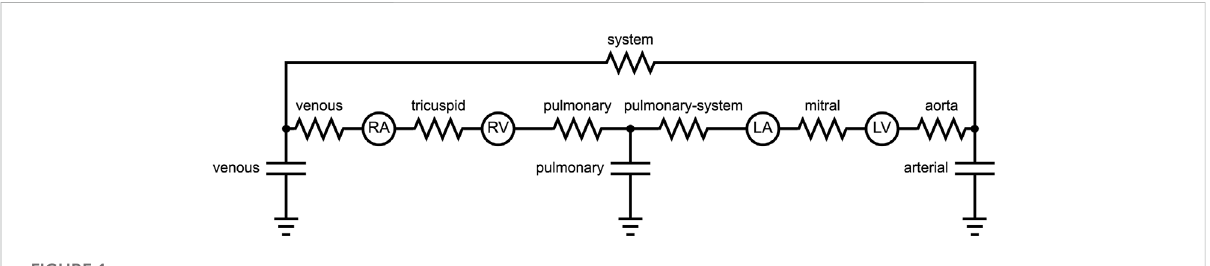
FIGURE 1 Electrical representation of the blood fl ow model.